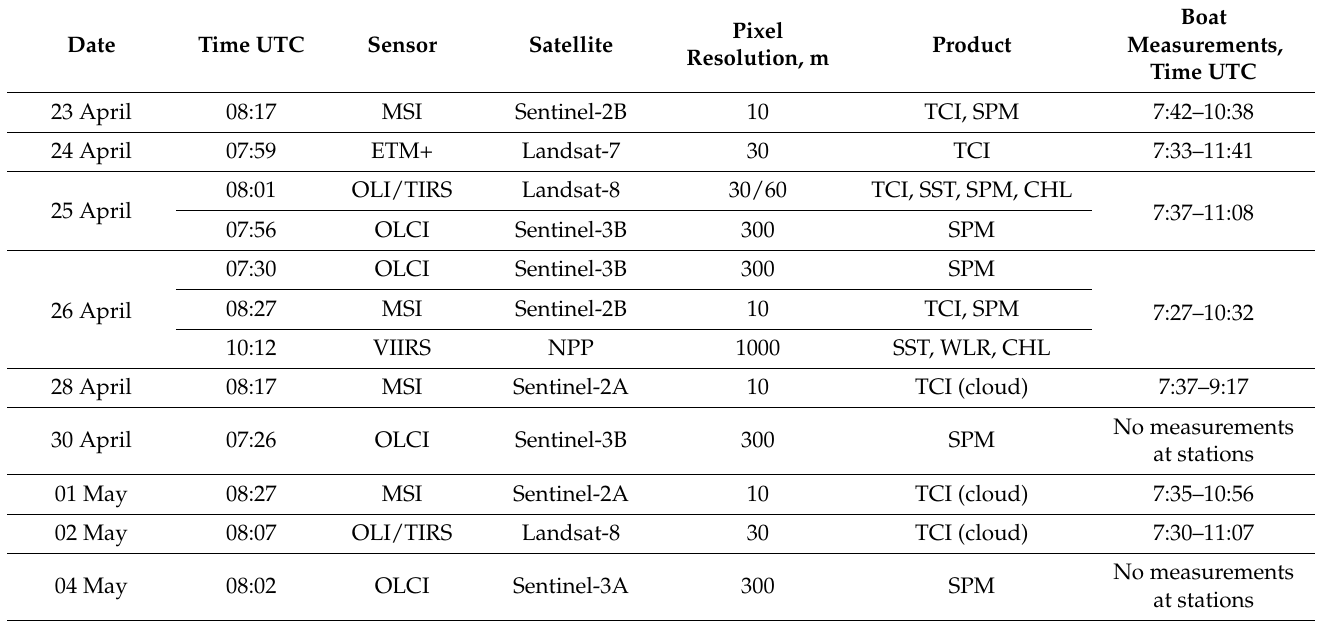
Table 5. Satellite information available during field measurements.